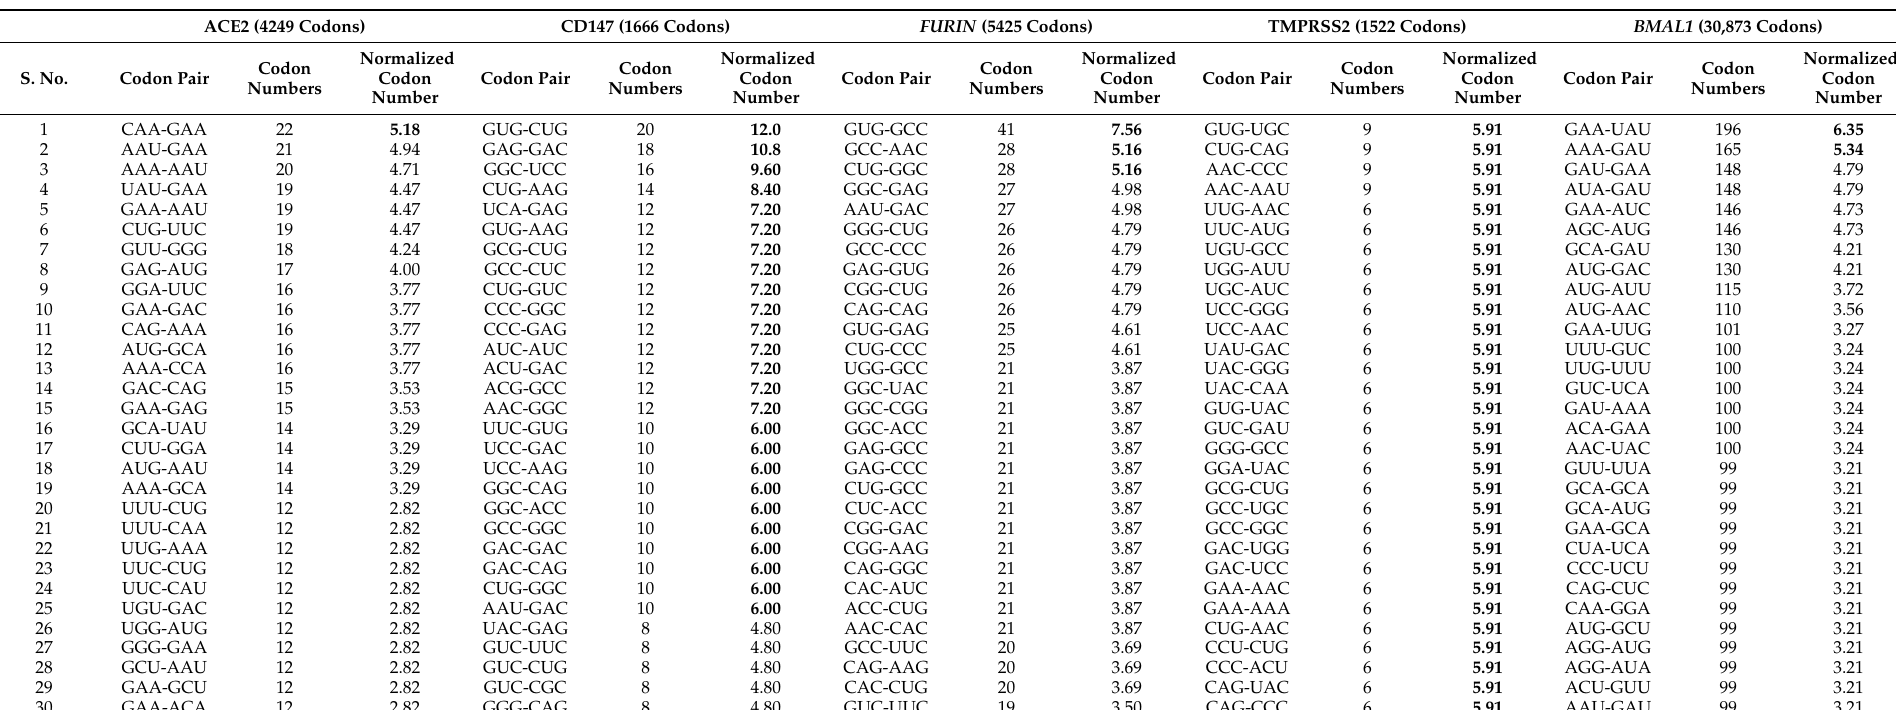
Table 2. Table presenting codon numbers and normalized codon numbers in transcripts of genes. Normalized codon pair numbers above a value of 5 (five codon pairs per thousand codon pairs) are indicated in